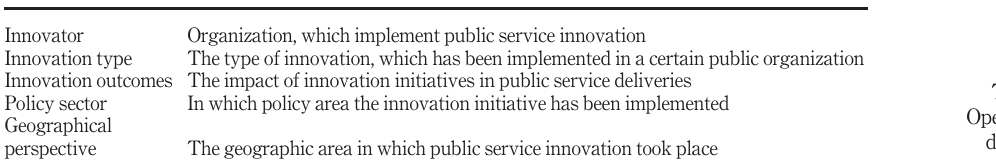
Figure 1. Backbones of